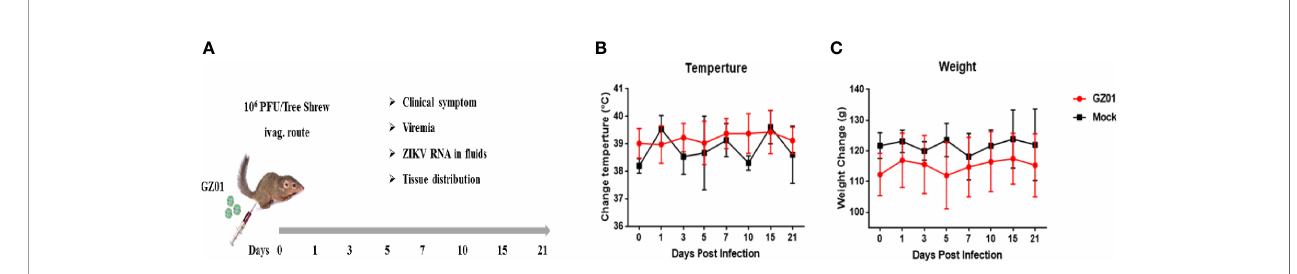
FIGURE 1 | (A) Experimental design and sampling index. (B) Changes in body temperature. (C) Body weight of tree shrews after ZIKV